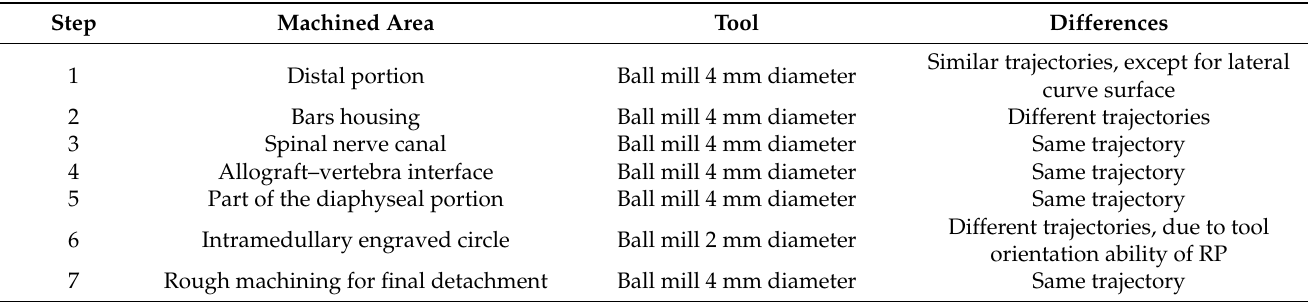
Table 1. Planned machining steps, with definition of the machined area, used tool, and main trajectories differences between CNC (computer numerical control, 4-axes) and RP (robot prototype, 5-axes)